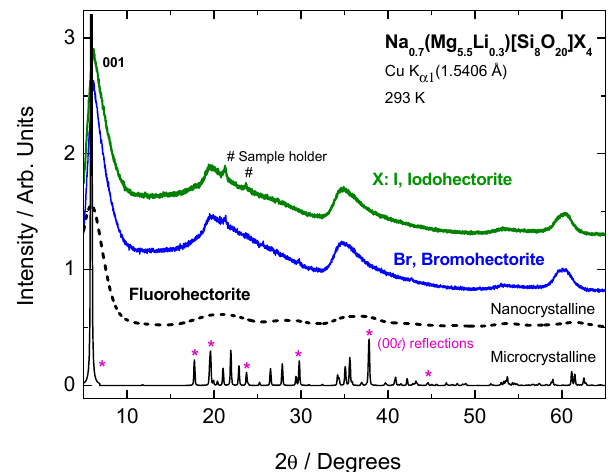
Figure 1. The XPD patterns of the bromohectorite and iodohectorite. The reference patterns for nano- and microcrystalline fluorohectorite were calculated with PowderCell v 2.4 program (W. Kraus and G. Nolze, BAM, Berlin, Germany, 2000) using structural data from [30].